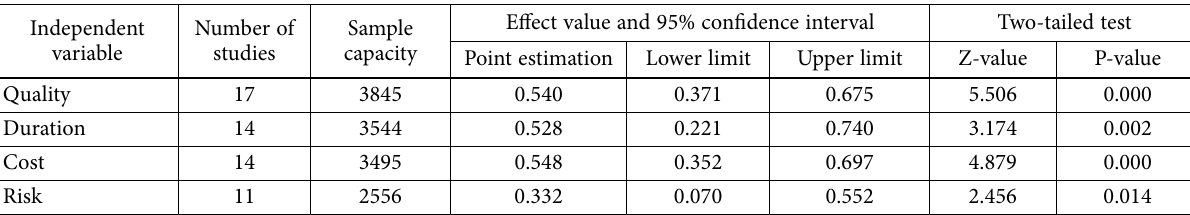
Table 4. Random model analysis of the relationship between quality, duration, cost, risk and engineering harmony